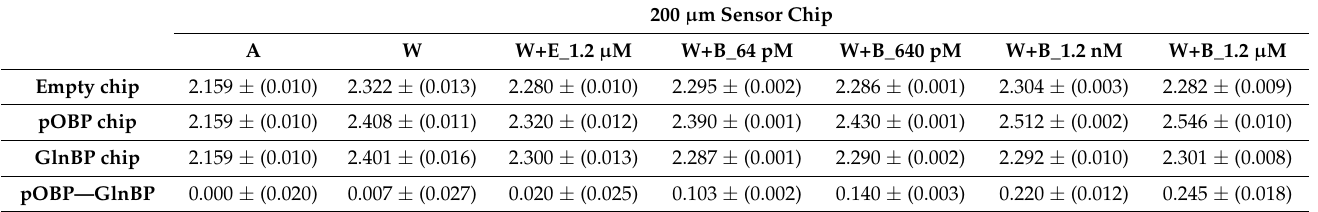
Figure 3. Sensor measurements in solution. Variation of the voltage in the absence (dry, water, and ethanol) and in the presence of different concentrations of benzene (64 pM and 1.2 µM) by using the 200 µm sensor chip.